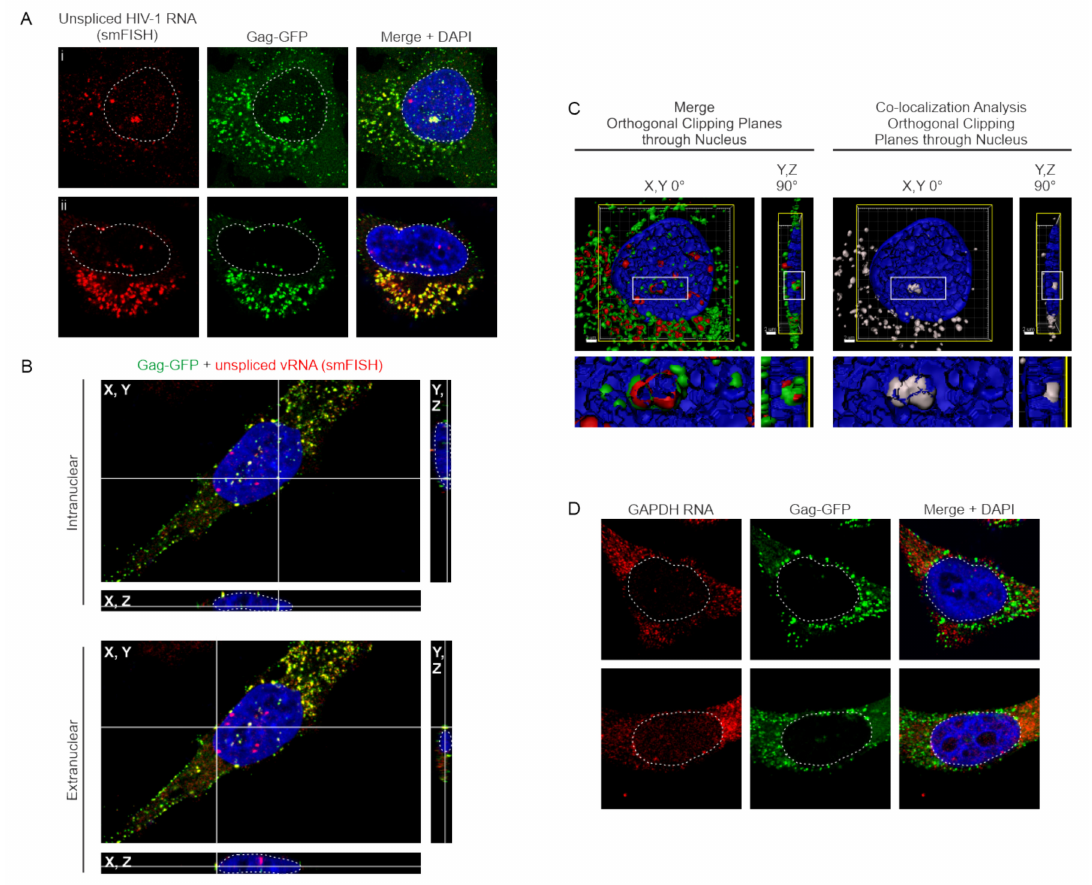
Figure 3. HIV-1 Gag co-localizes with USvRNA in the nuclei of HeLa HIV.Gag-GFP rtTA cells. ( A ) Two di ff erent cells (panels i and ii) showing co-localization of HIV-1 Gag-GFP (green), USvRNA (red, detected by smFISH), and co-localized foci (yellow) in the nucleus (DAPI-stained, shown as blue, outlined in white), cytoplasm, and along the plasma membrane of dox-induced HIV-1 Gag-GFP rtTA cells. ( B ) Cross-sections of dox-induced HeLa HIV.Gag-GFP rtTA cells containing nuclear HIV-1 Gag-GFP foci co-localized with USvRNA within intranuclear and extranuclear space, as indicated. Gag-USVRNA co-localized foci located at the intersection of the white cross hairs) are depicted in X, Y (center); Y, Z (right); and X, Z (bottom) planes, with the DAPI-stained nucleus (blue) outlined with a white dashed line. ( C ) Left, Three-dimensional surface rendering exhibiting HIV-1 Gag (green) and USvRNA (red) co-localization within a single orthogonal clipping through the XY plane of the nucleus. Right, Co-localization analysis of Gag-USvRNA co-localized foci (white) using Imaris. Images were depicted in the XY (center) and YZ (rotated 90 ◦ ) planes with scale bars = 2 µ m (white). vRNP foci can be seen located in the perichromatin (DAPI-poor) space. ( D ) GAPDH RNA (detected using smFISH; red) and HIV-1 Gag-GFP (green) have negligible co-localization within the nucleus (DAPI-blue, white